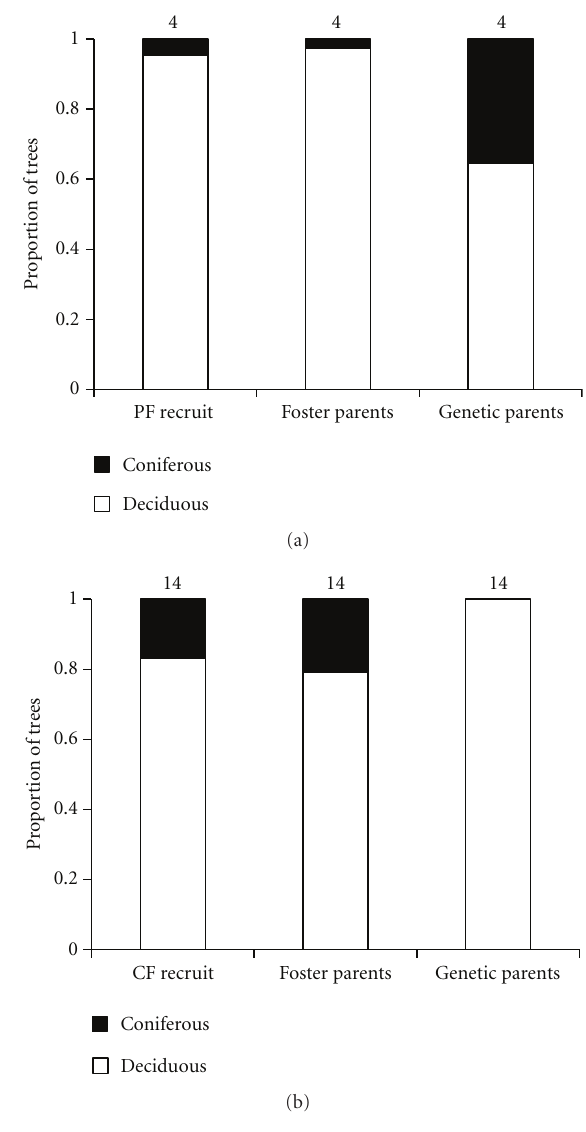
Figure 6: Habitat composition in the breeding territories of cross- fostered yearling pied (a) and collared flycatchers (b) as compared to the breeding territories of their foster parents and genetic parents on ¨Oland, Sweden, 2002–2009. Both pied and collared flycatcher recruits returned to breed in a habitat di ff erent from their genetic parents. Only recruits that were swapped between di ff erent nest-box areas are included in this comparison, sample sizes are given above the